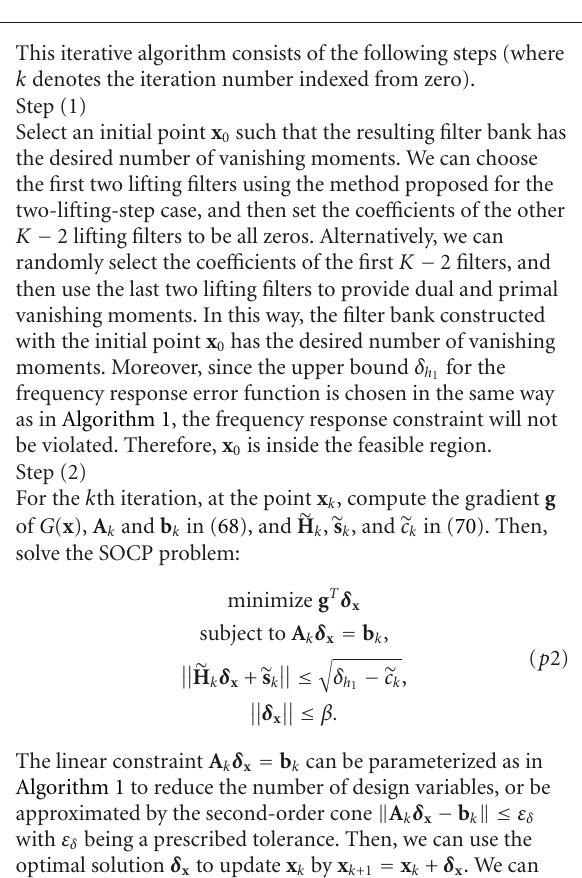
Algorithm 2: More-than-two lifting-step